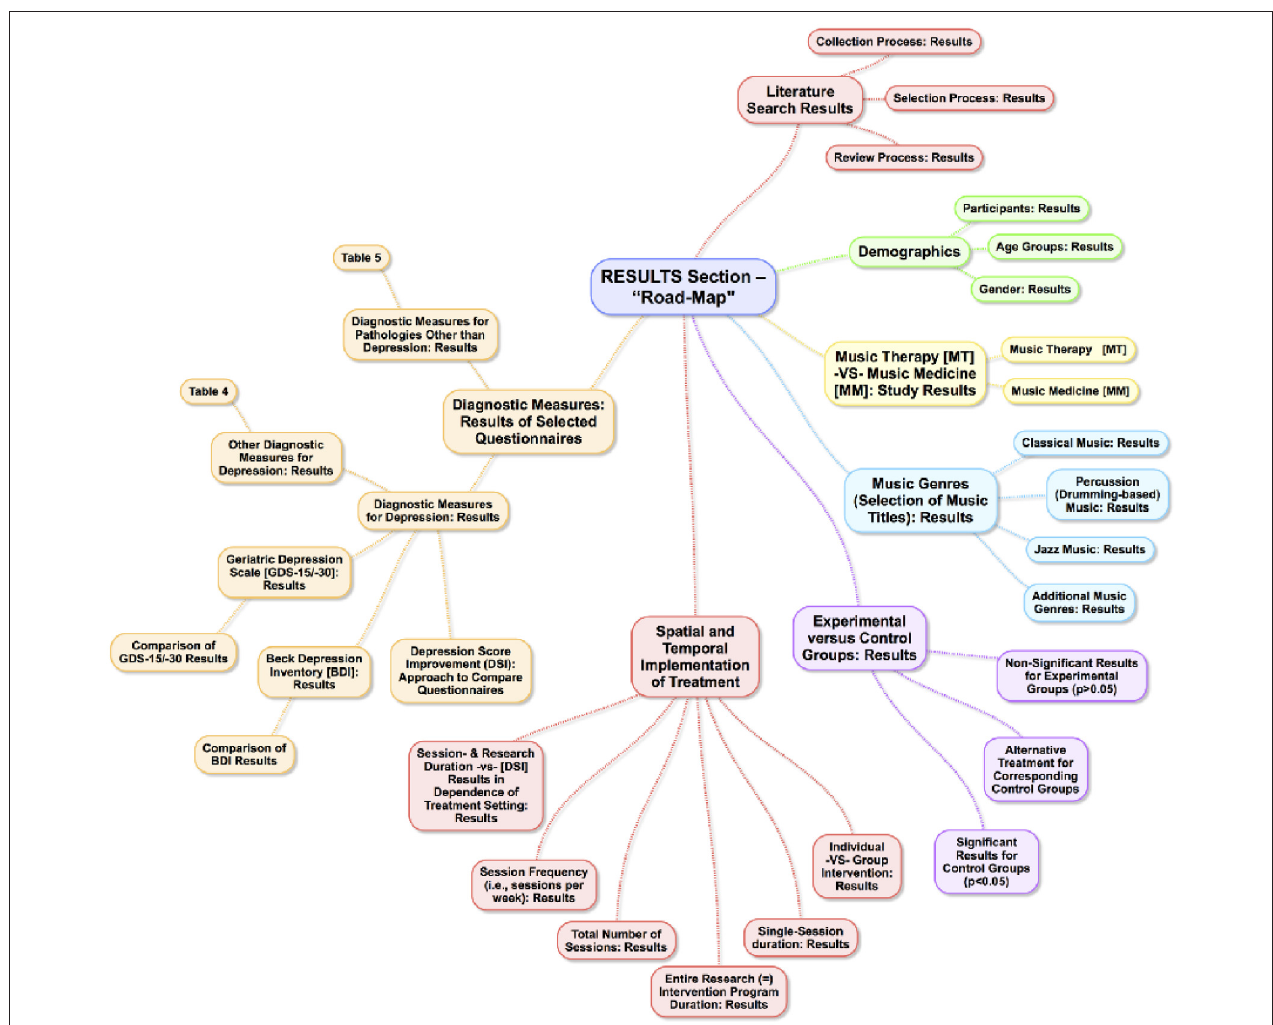
FIGURE 1 | “Road-Map” Outline of the following results section (idea, concept and creation of this Figure by Leubner).